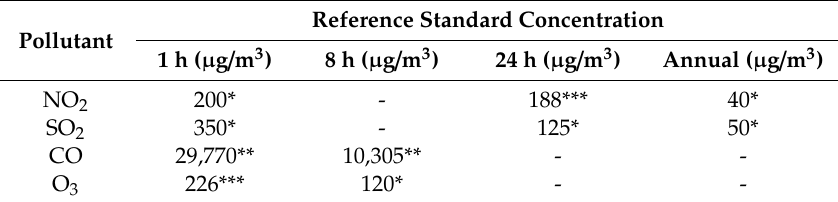
Table 1. Reference ambient standards for CO, NO 2 , SO 2 , and O